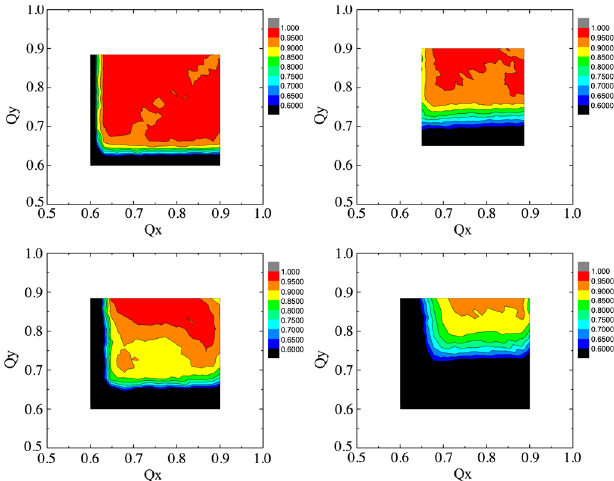
FIG. 8. Tune scans of the transmission efficiency over the first millisecond after injection: (a) (top left) at the N p ¼ 0 . 95 × 10 12 and ¼ − 6 = – 6 ;(b)(top right) N ¼ 0 . 95 × 10 12 and Q 0 ¼ − 20 = – 20 ; Q 0 x;y x;y p (c) (bottom left) N p ¼ 4 . 3 × 10 12 and Q 0 x;y ¼ − 16 = – 4 ; (d) (bottom right) N p ¼ 4 . 3 × 10 12 and Q 0 x;y ¼ − 20 = – 20